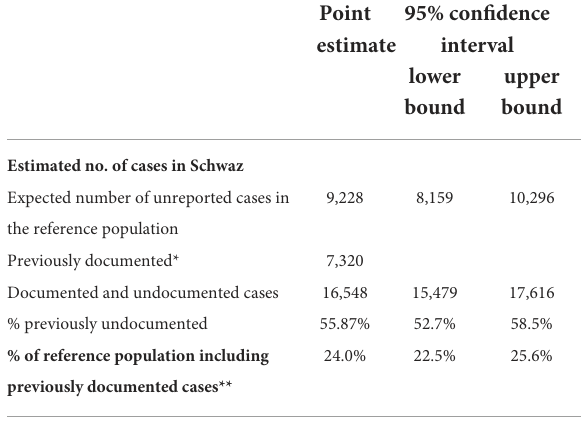
TABLE 4 Projected undocumented and overall point prevalence of SARS-SoV-2 infection in the district of Schwaz just before the mass immunization